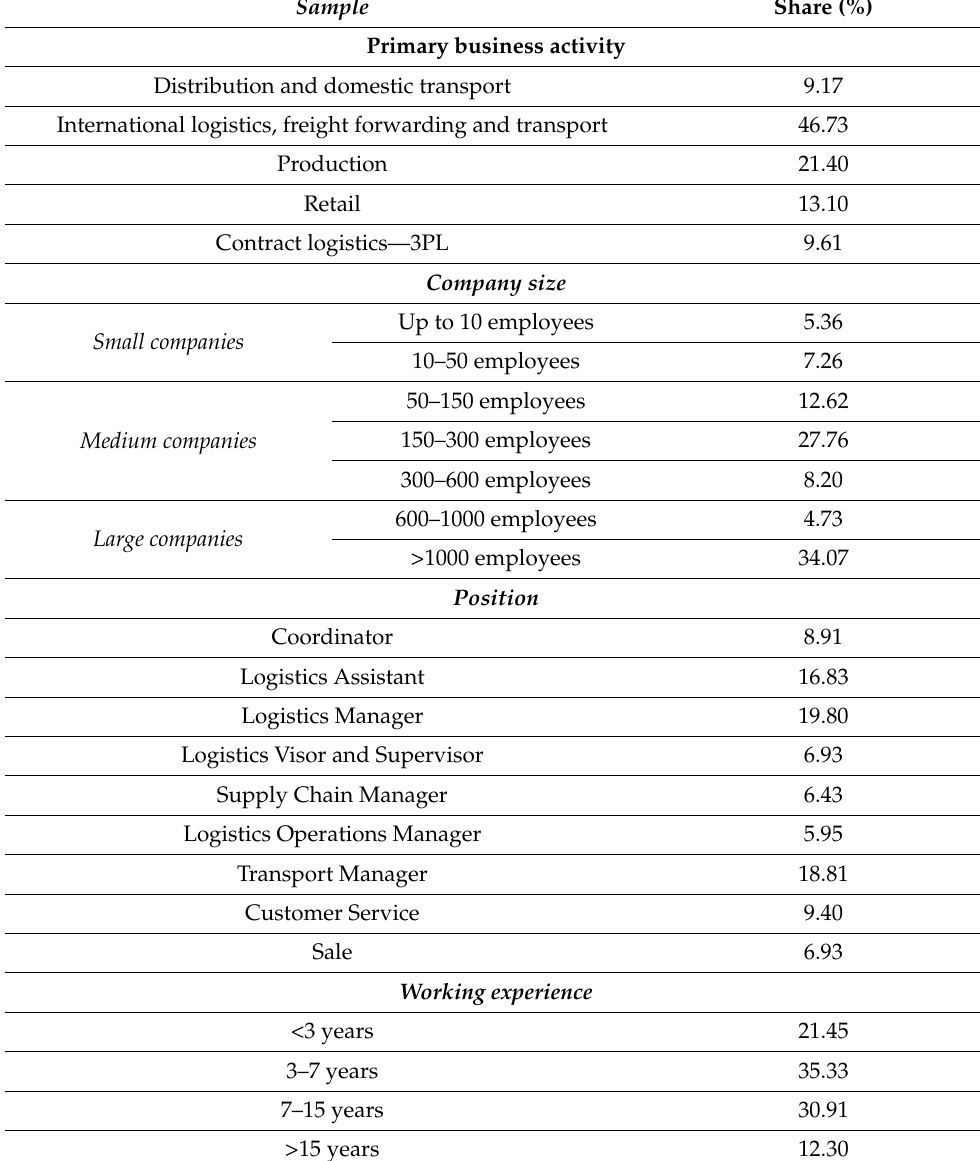
Table 2. Descriptive